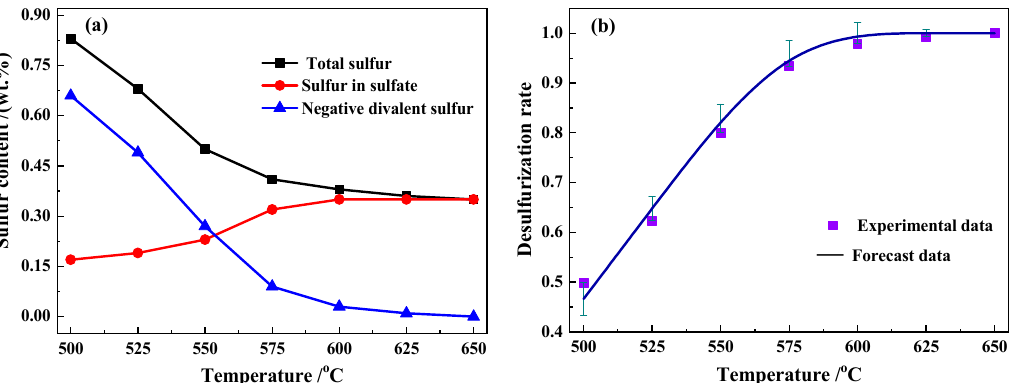
Figure 9. Effect of temperature on the ( a ) sulfur content and ( b ) desulfurization rate of high-sulfur bauxite.